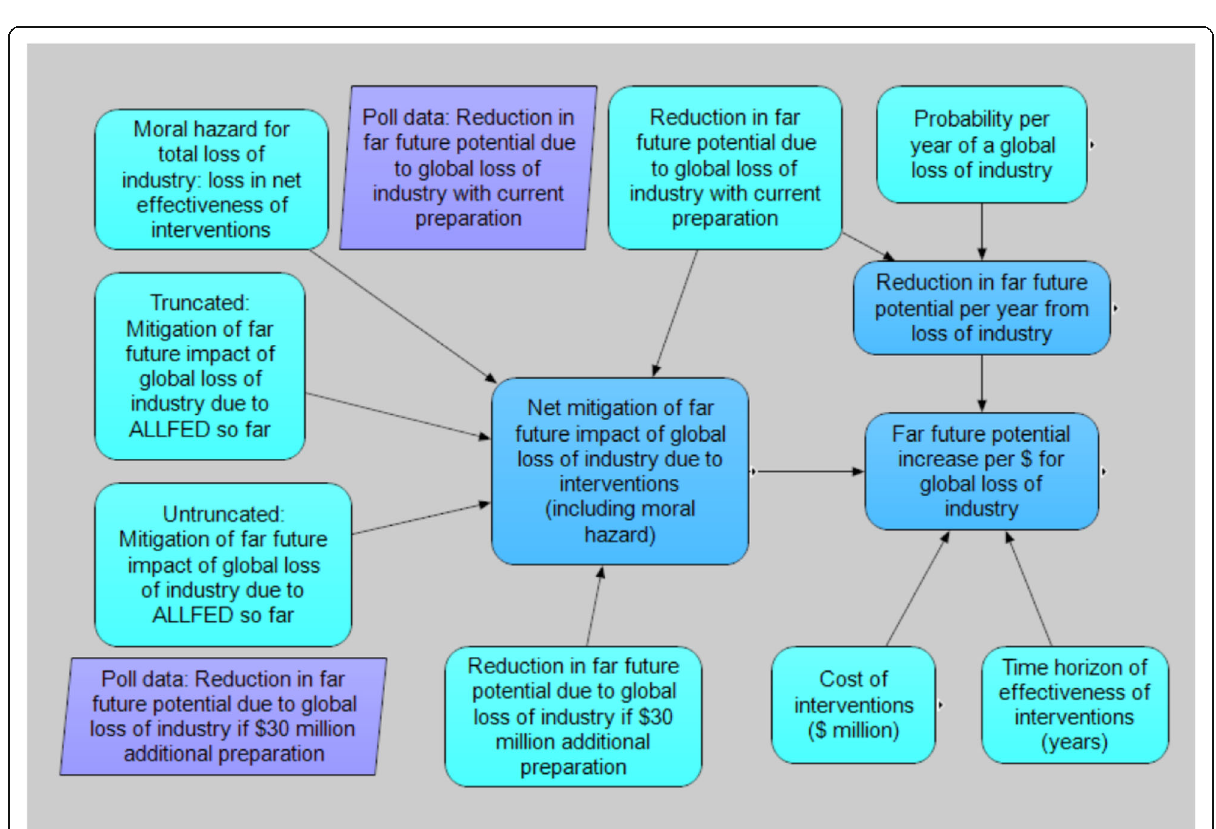
Fig. 3 Global industry loss submodel (10% industry loss is nearly